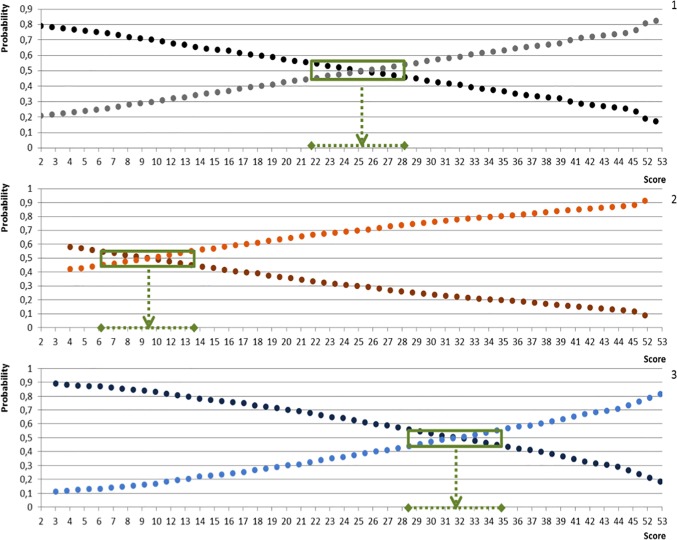
Probability curves of the entire population, Golden Retriever, and Labrador Retriever.Probability graph for the entire population (1), Golden Retrievers (2), and Labrador Retrievers (3): The dark and light dotted lines represent the probabilities for the development of FCI A and B hips, respectively. The green square marks the zone in which the probability is between 45% and 55%. In this zone, the score range from 22 to 28 for the entire population, from 6 to 14 for the Golden Retrievers, and from 28 to 35 for the Labrador Retrievers.